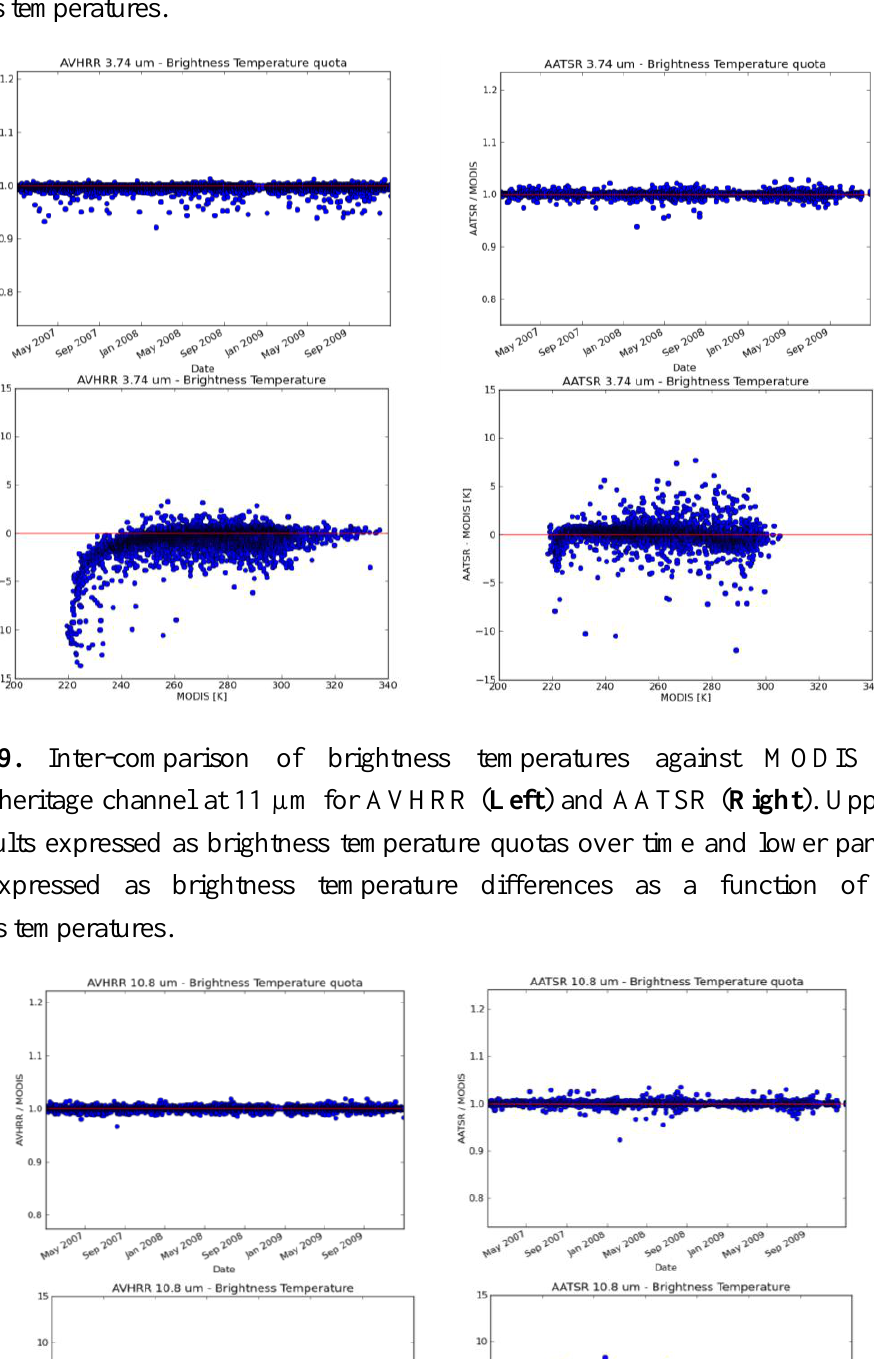
Figure 8. Inter-comparison of brightness temperatures against MODIS for the AVHRR-heritage channel at 3.7 µm for AVHRR ( Left ) and AATSR ( Right ). Upper panels show results expressed as brightness temperature quotas over time and lower panels show results expressed as brightness temperature differences as a function of MODIS brightness temperatures.